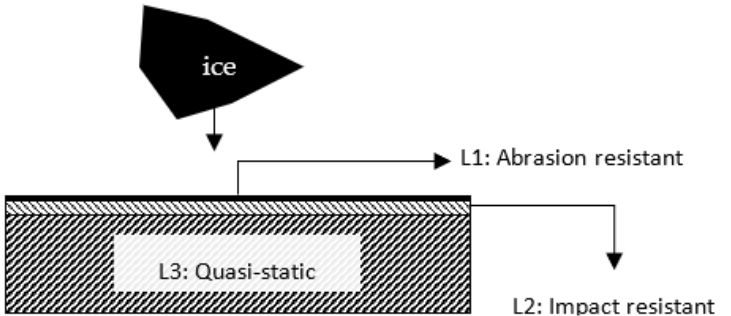
Figure 2. Proposed structural concept for an ice-going hull consists of three layers specialized in handling quasi-static loads (L3), dynamic loads (L2) and abrasion due to ice scraping (L1).